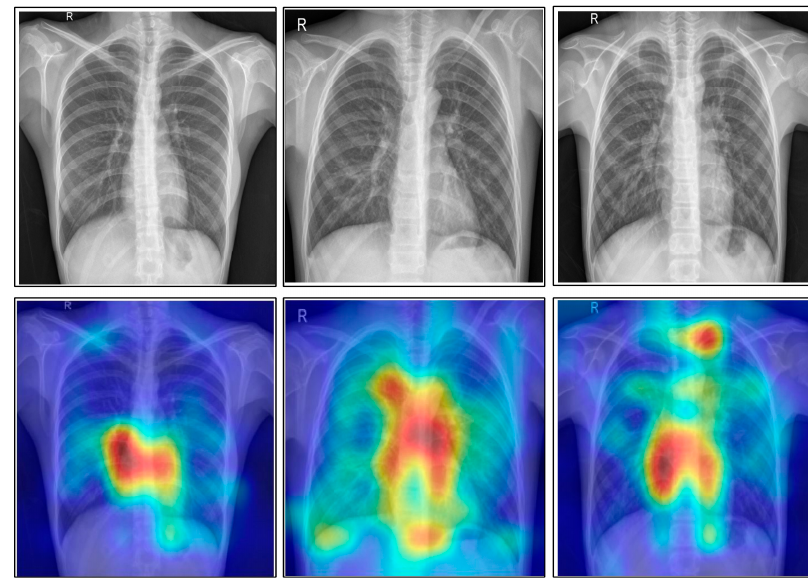
Figure 17. Grad-CAM-based infected region visualization.